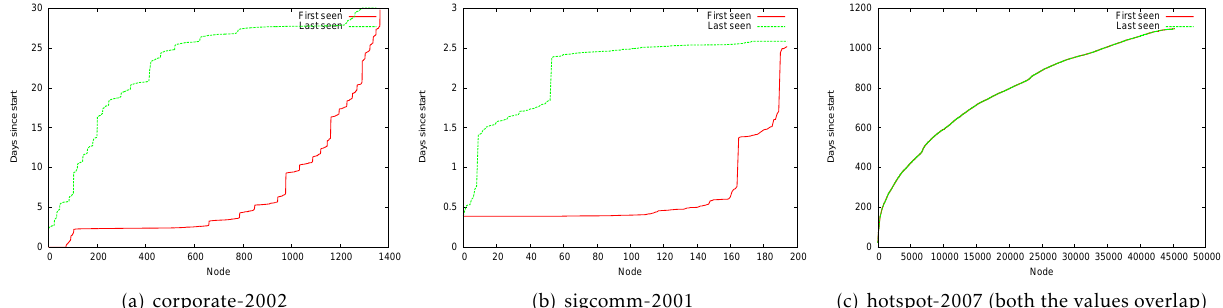
Figure 7. User churn behavior (academia)